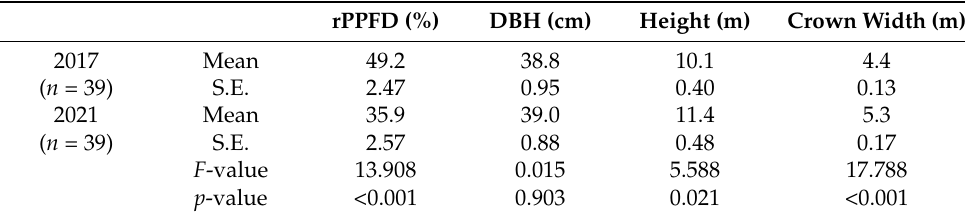
Table 1. Summary of the orchard status in terms of relative photosynthetic photon flux density (rPPFD), diameter at breast height (DBH), tree height and crown radius in 2017 and 2021. rPPFD (%) DBH (cm) Height (m) Crown Width (m) 2017 Mean 49.2